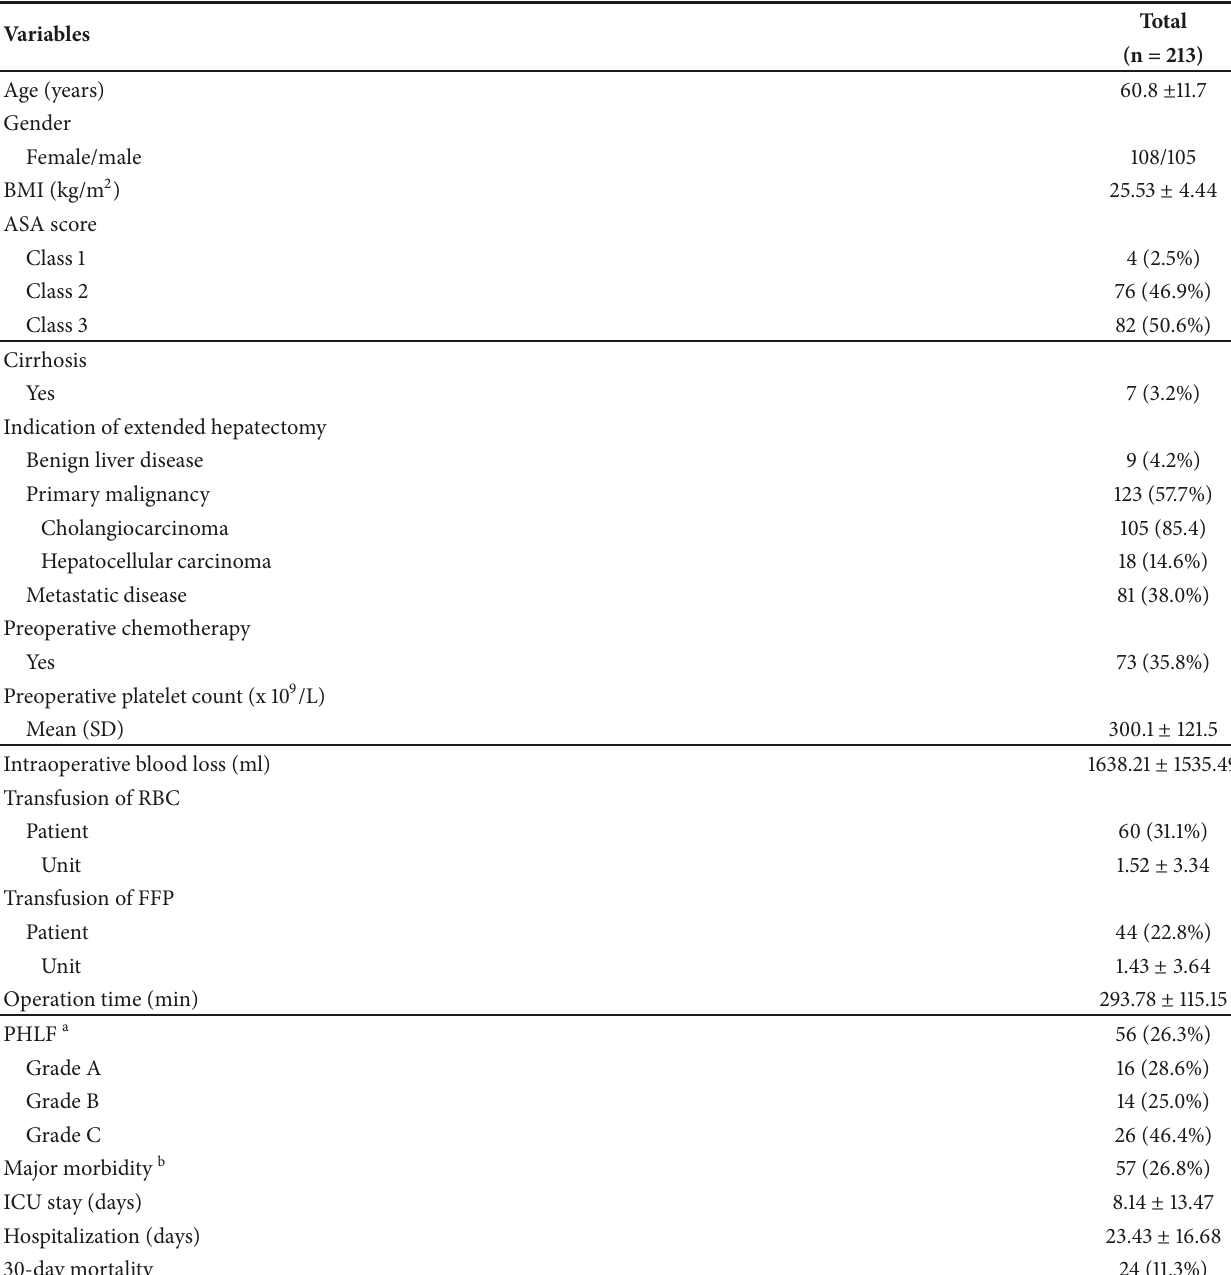
Table 1: Clinicopathologic characteristics of patients who underwent extended